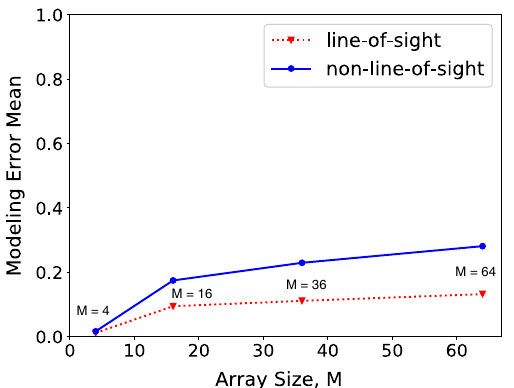
Fig. 6 Average modeling error changing with the number of base-station antennas. The plot is based on measured line-of-sight and non-line-of-sight channels,